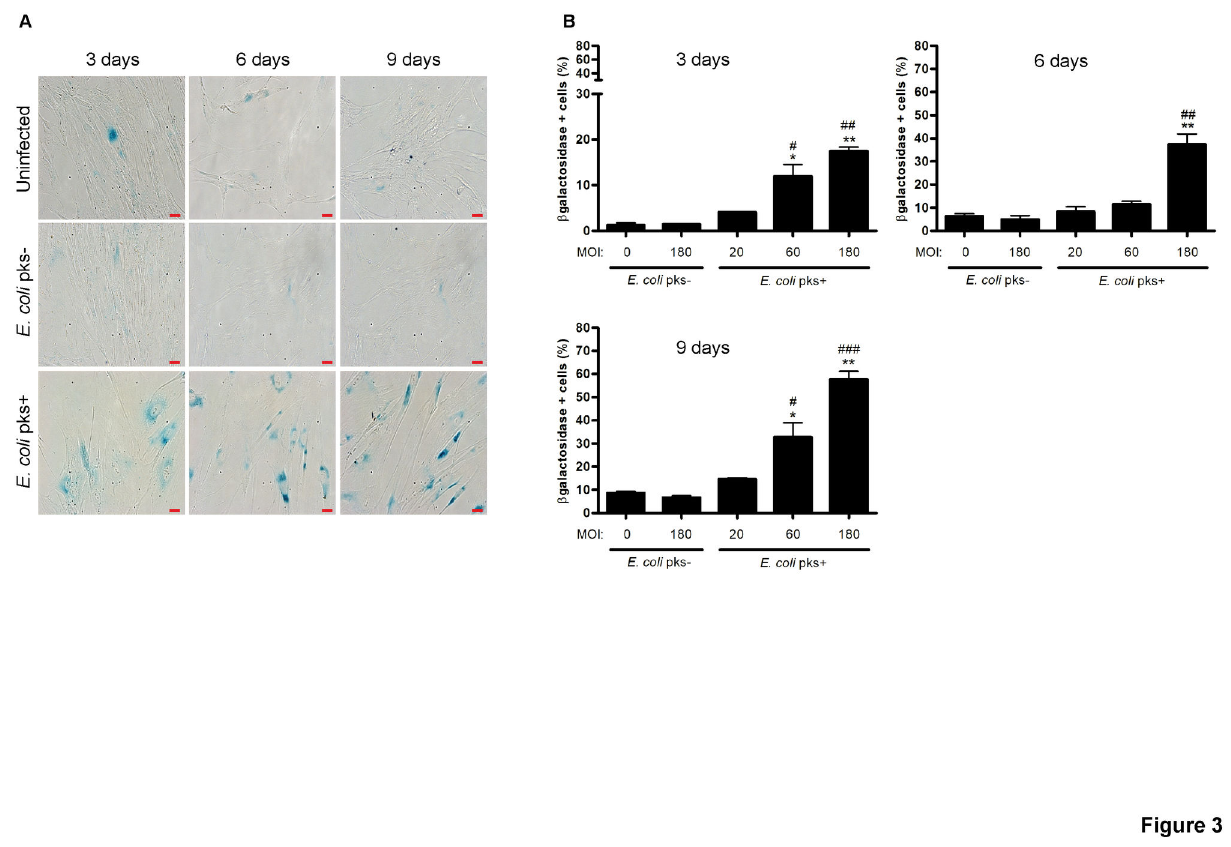
Figure 3. Increased senescence associated (SA)-β-galactosidase activity in IMR-90 cells infected with pks + E. coli. 3, 6 or 9 days after infection, IMR90 cells were fixed with formaldehyde 4% and then stained with the galactosidase chromogenic substrate X-gal at pH 6 for 24h. Cells were examined for perinuclear blue staining by light microscopy at x20 magnification (A), and these SA- β-Gal positive cells (100-200 cells per condition) were quantified by a blinded observer (B). Results represent the mean and SEM of three independent experiments, one-way ANOVA with Bonferroni’s multiple comparison test; *P<0.05, **P<0.01 comparing infected and uninfected groups; #P<0.05, # #P<0.01, # # #P<0.001 comparing pks + and pks - groups. doi: